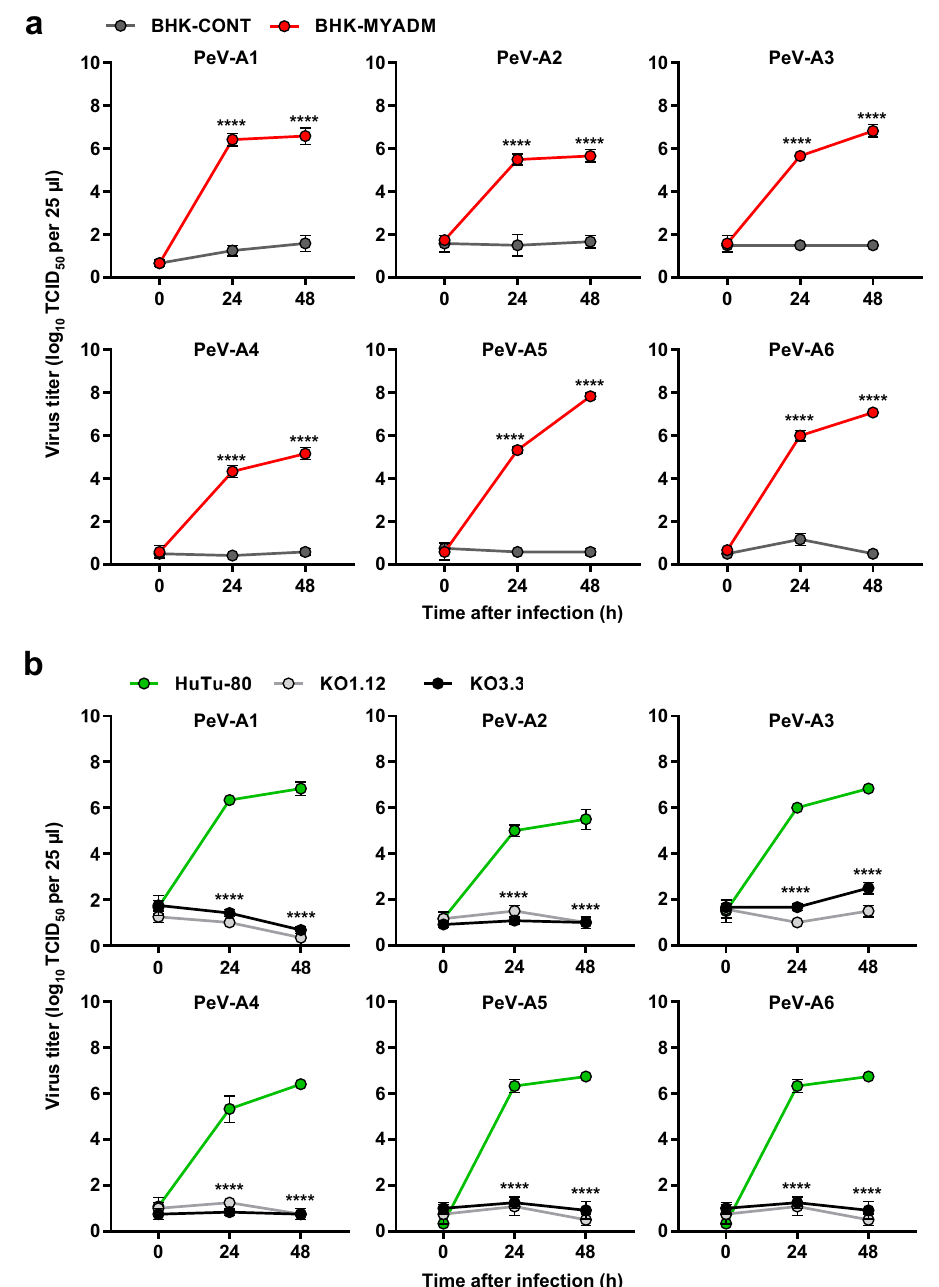
Fig.4|MYADMisessentialforinfectionofsixPeV-Agenotypes.a BHK-MYADM (red circle) and BHK-CONT(dark gray circle)cells were infected with the indicated PeV-A genotypes at an MOI of 0.01, and the amount of virus (virus titer) in the culture supernatant wasmeasured at0, 24and 48h afterinfection.The virus titers intheculturesupernatantareshownasthemean±s.d.fromtriplicateexperiments. Data from one experiment representative of two independent experiments ( N =2) are shown. b HuTu-80 (green circle), MYADM-KO1.12 (light gray circle) and KO3.3